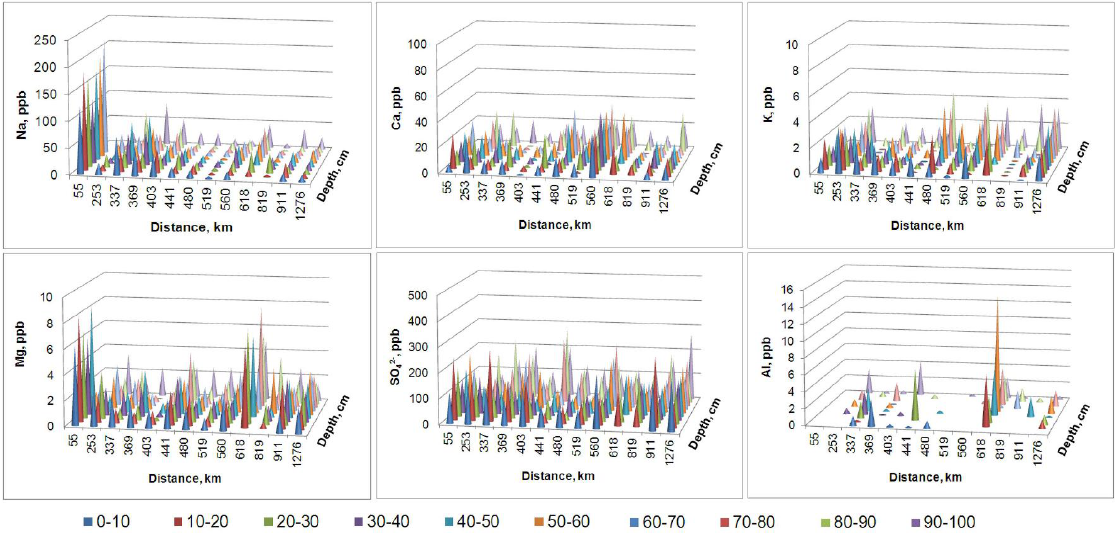
Fig. 3. Matrix diagram of measured ion concentrations in snow samples within the 0–100cm snow layer along the